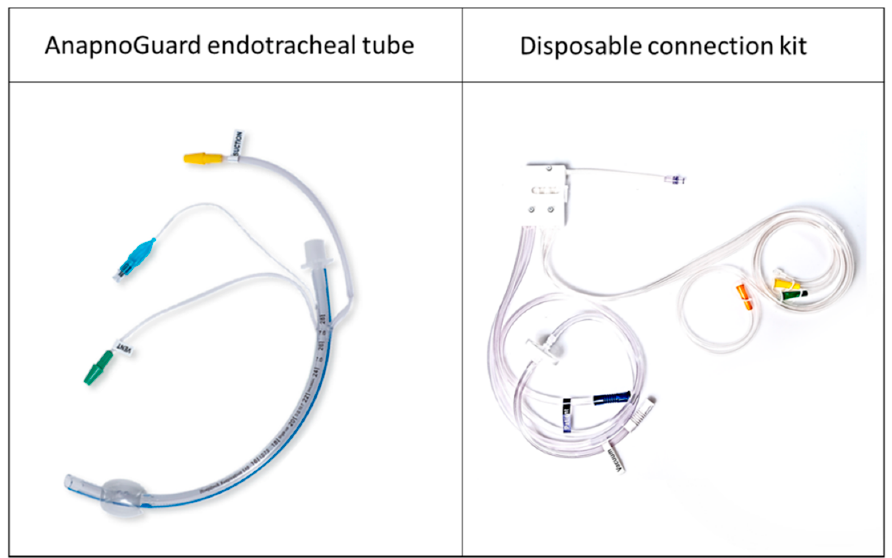
Figure 12. Single-use disposables.